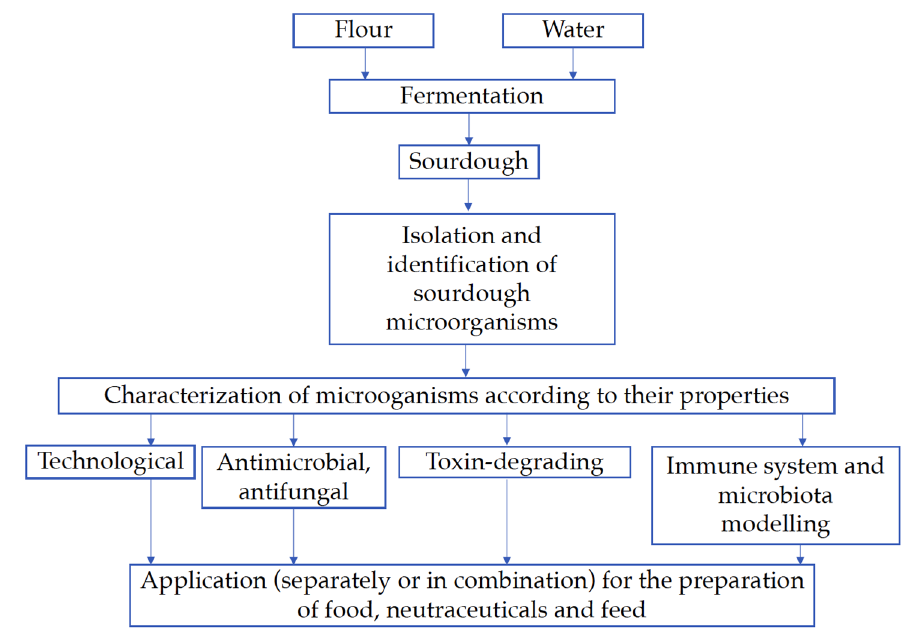
Figure 1. Schematic representation of the brief introduction of this review.